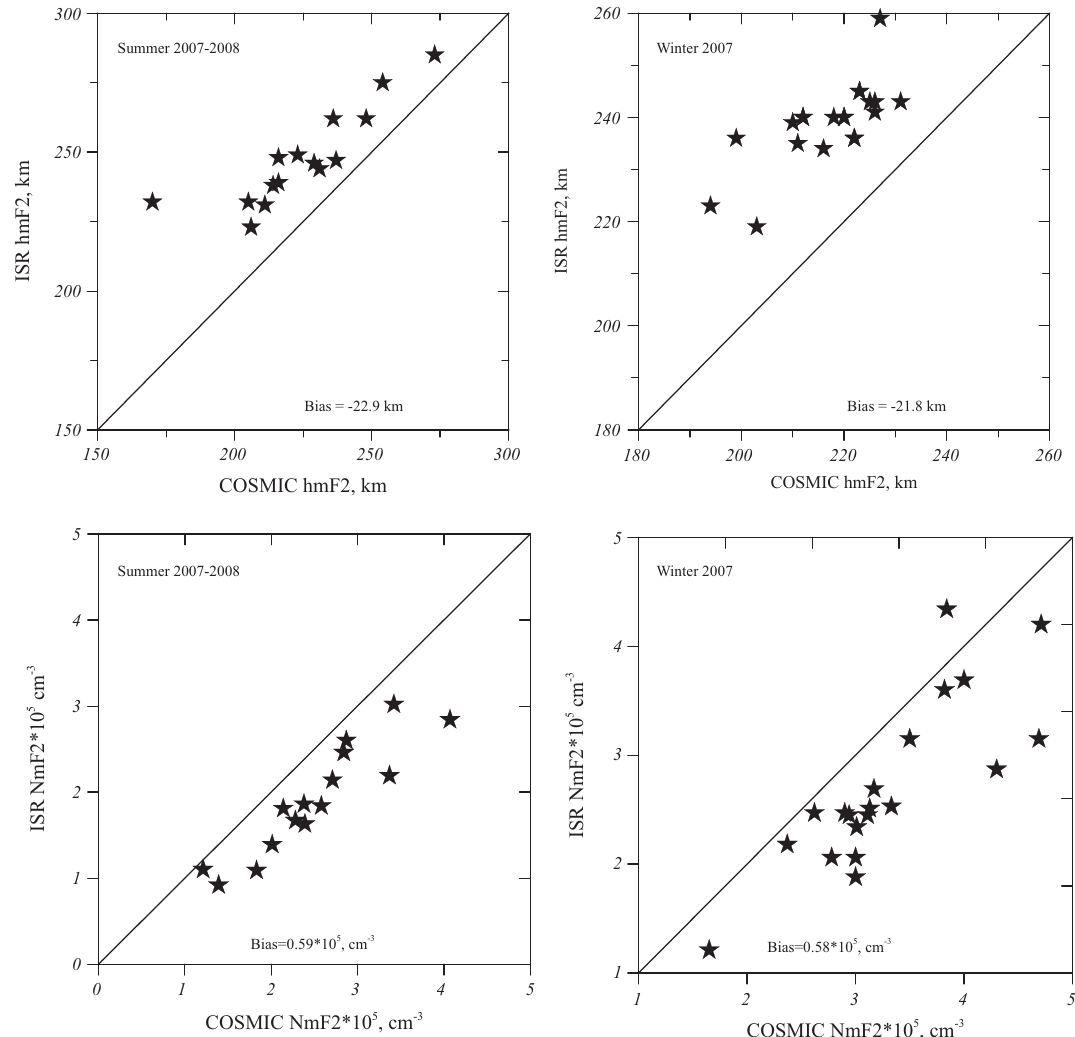
Fig. 4. Scatterplots of hmF2 and NmF2 determined by Millstone Hill ISR vs. RO method.